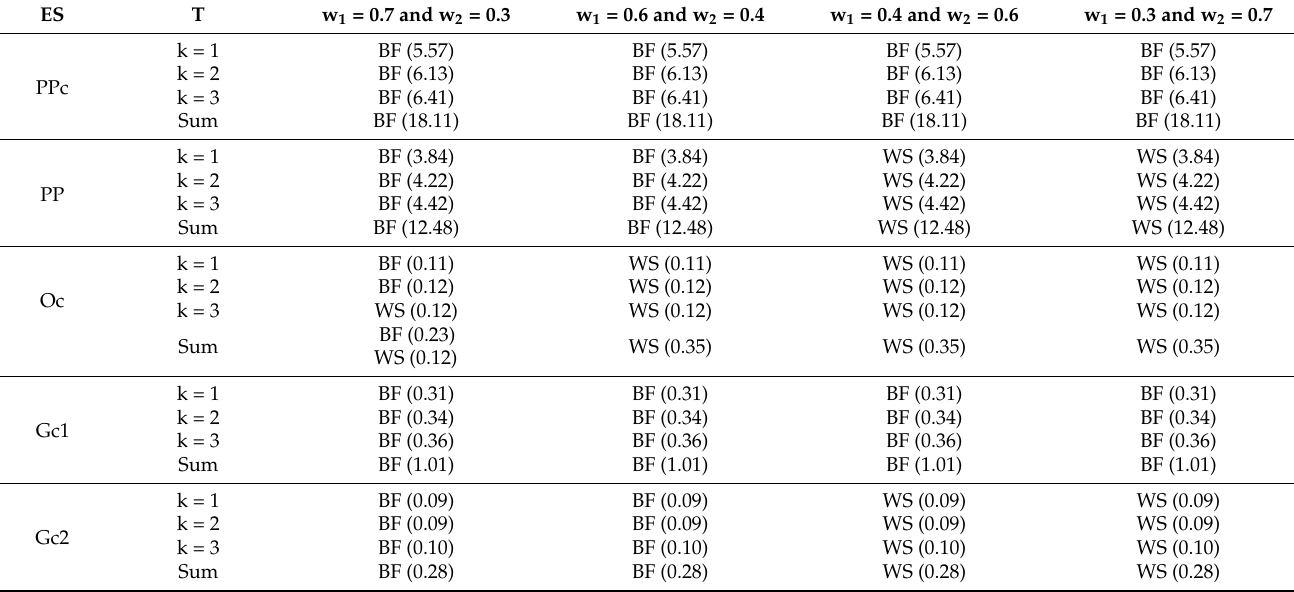
Table 4. The optimal treated PM magnitude of various techniques.